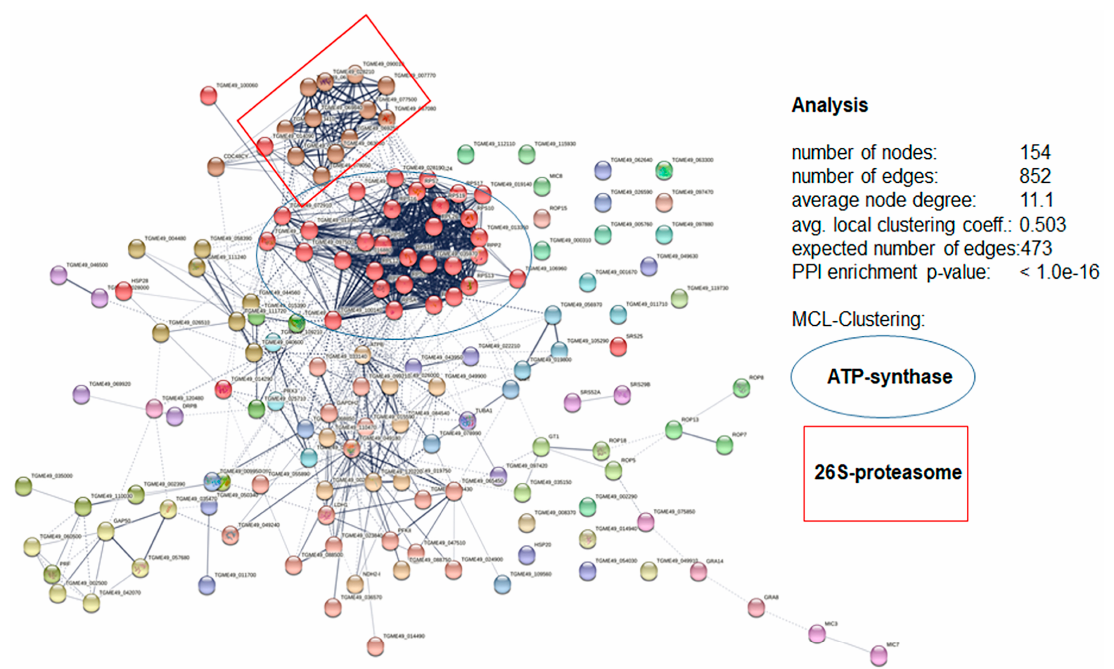
Figure 9. Protein–protein interaction network of proteins specifically binding to peptide 6027 in cell-free extracts of T. gondii RH tachyzoites based on the list of proteins given in Table S3. Two major clusters, namely ATP-synthase (blue ellipse) and the 26S-proteasome (red rectangle). are highlighted. The interaction network was created by the STRING knowledgebase and software tool from the Swiss Institute of Bioinformatics (www.expasy.org).